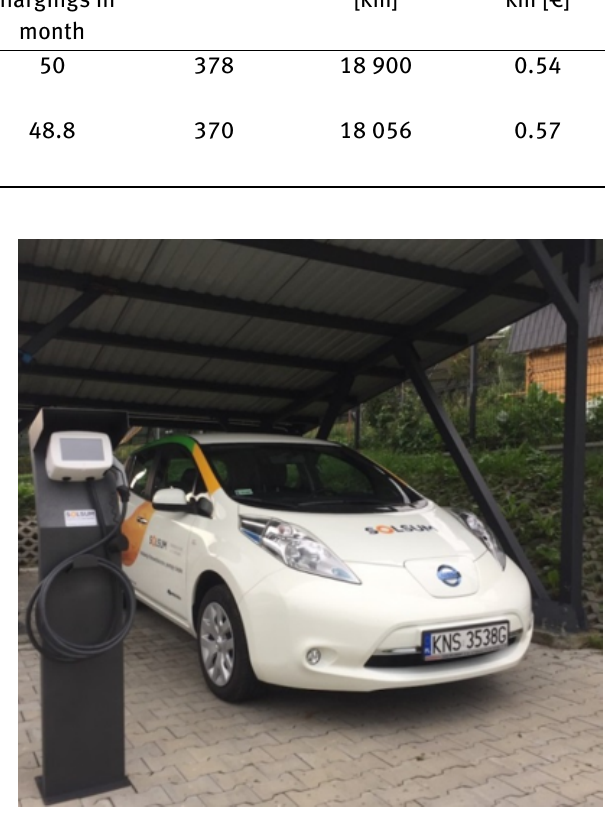
Power of on-board charger [kW]